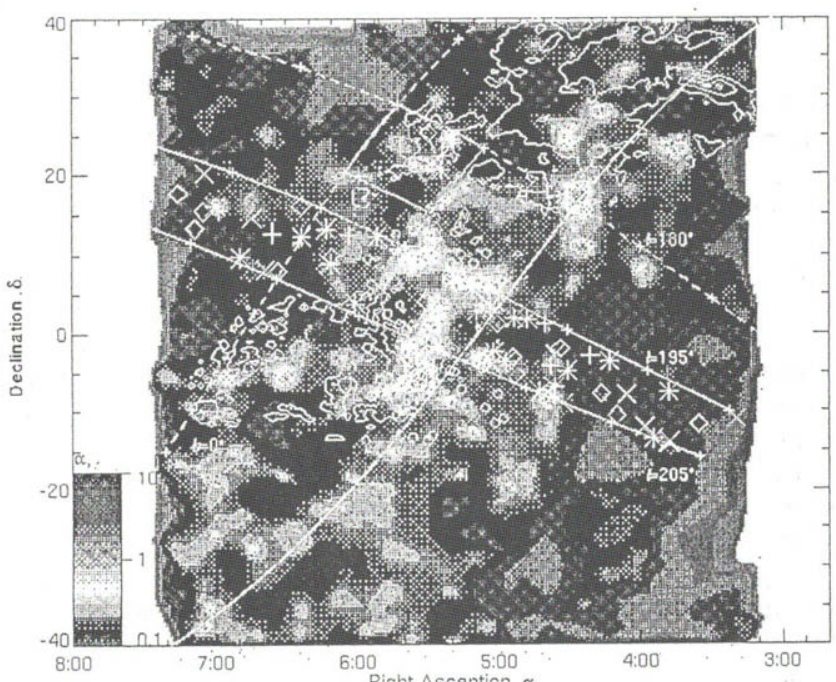
Fig. 3. The galactic plane is the dashed line. The contours of molec- ular clouds in Orion and Taurus-Auriga are shown, together with the grey-coded space densities of the RASS sources. In the strip between i — 195 deg and t = 205 deg, candidates have also been observed for lithium. The lithium-rich sources (crosses) cluster preferentially in the Gould Belt (represented by the continuous line), while the lithium-poor ( x) and the no-lithium sources (diamonds) are preferentially far from it (from Sterzik et al.